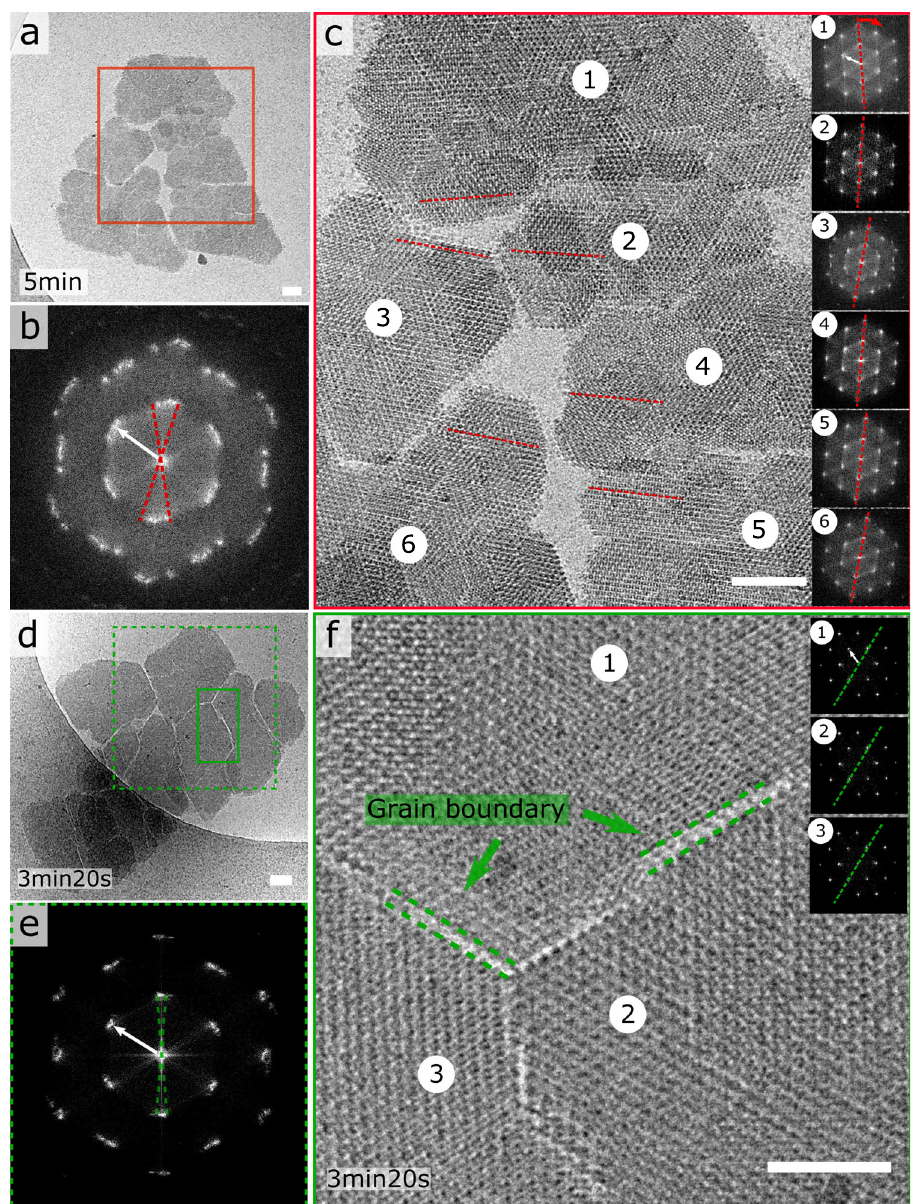
Fig. 2 GI R387A mesocrystals. a , c , d Large micron-sized composite nanocrystal structures with pronounced fault lines that separate lattice domains that are in near-alignment as demonstrated by their respective FFTs ( b , e ); zoom-in of the grain boundaries that span one or two molecular distances between the individual domains ( f ). The inset in panel ( f ) demonstrates the high degree of lattice order within each separate domain: domain 2 shown as representative example. Scalebar is 50 nm in panels a , c and d , and 25 nm in panel ( f ). White arrows in the FFT ’ s correspond to a resolution of 6.6